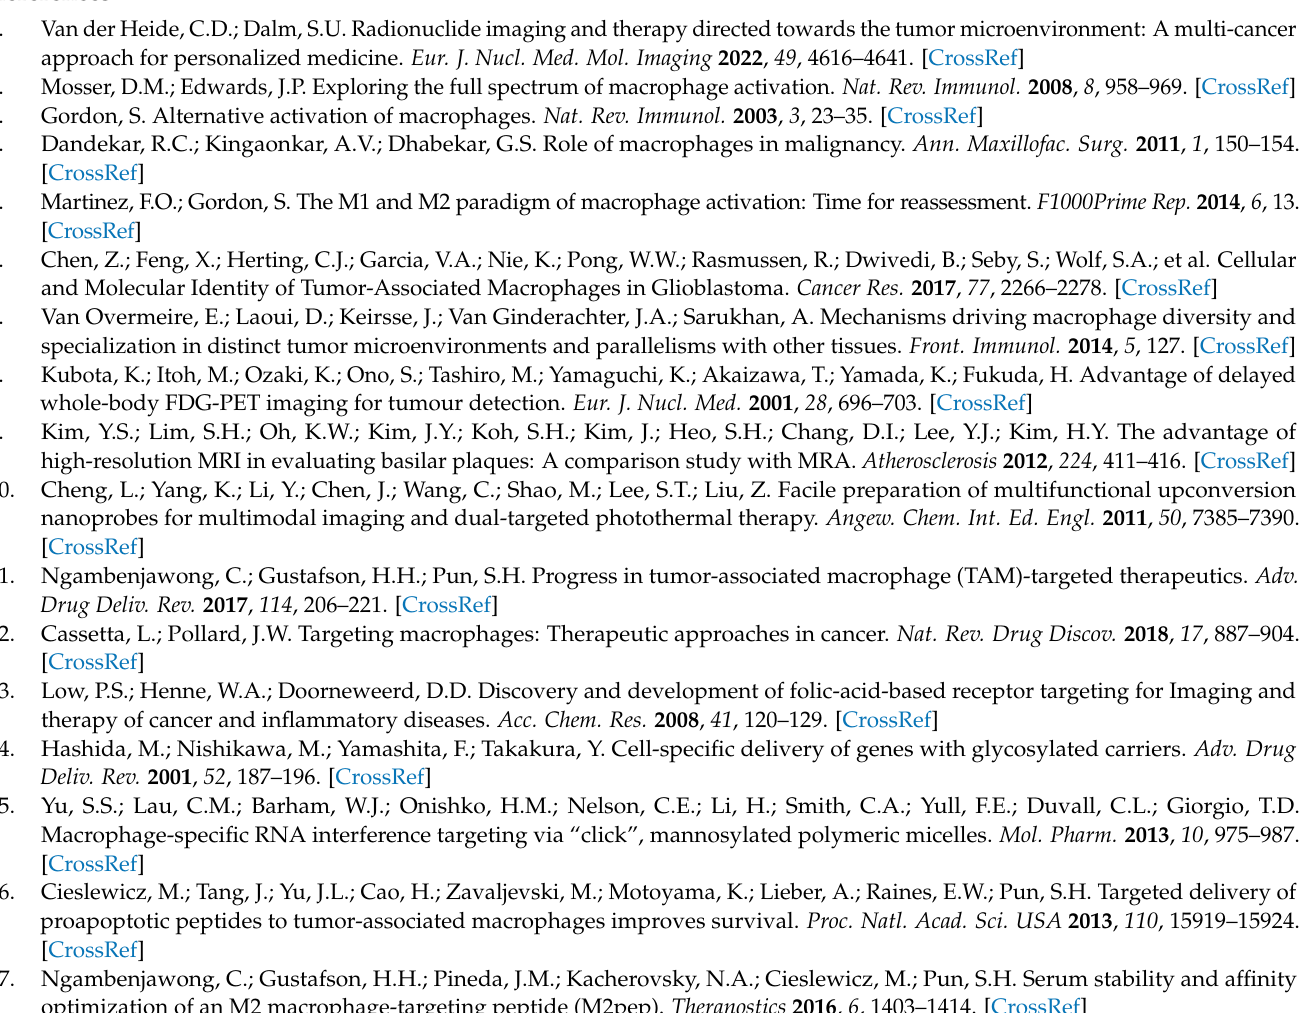
Figure A2. Identification of in vitro polarization of M2 macrophages. Bone-marrow-derived macro phages (BMDMs) were incubated with IL-4 (20 ng/mL) on day 6 for 48 h. Cells were collected and stained with PE-CD206. The positive percentage of PE-CD206 were measured by flow cytometry.